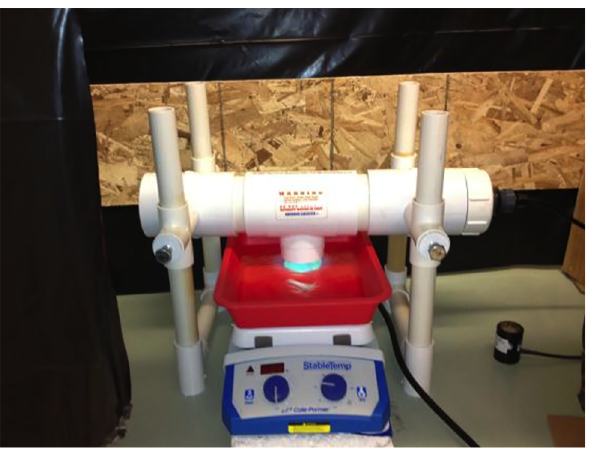
Fig 1. Laboratory setup. UV-C lamp set up as collimated beam. Data logging radiometer seen below